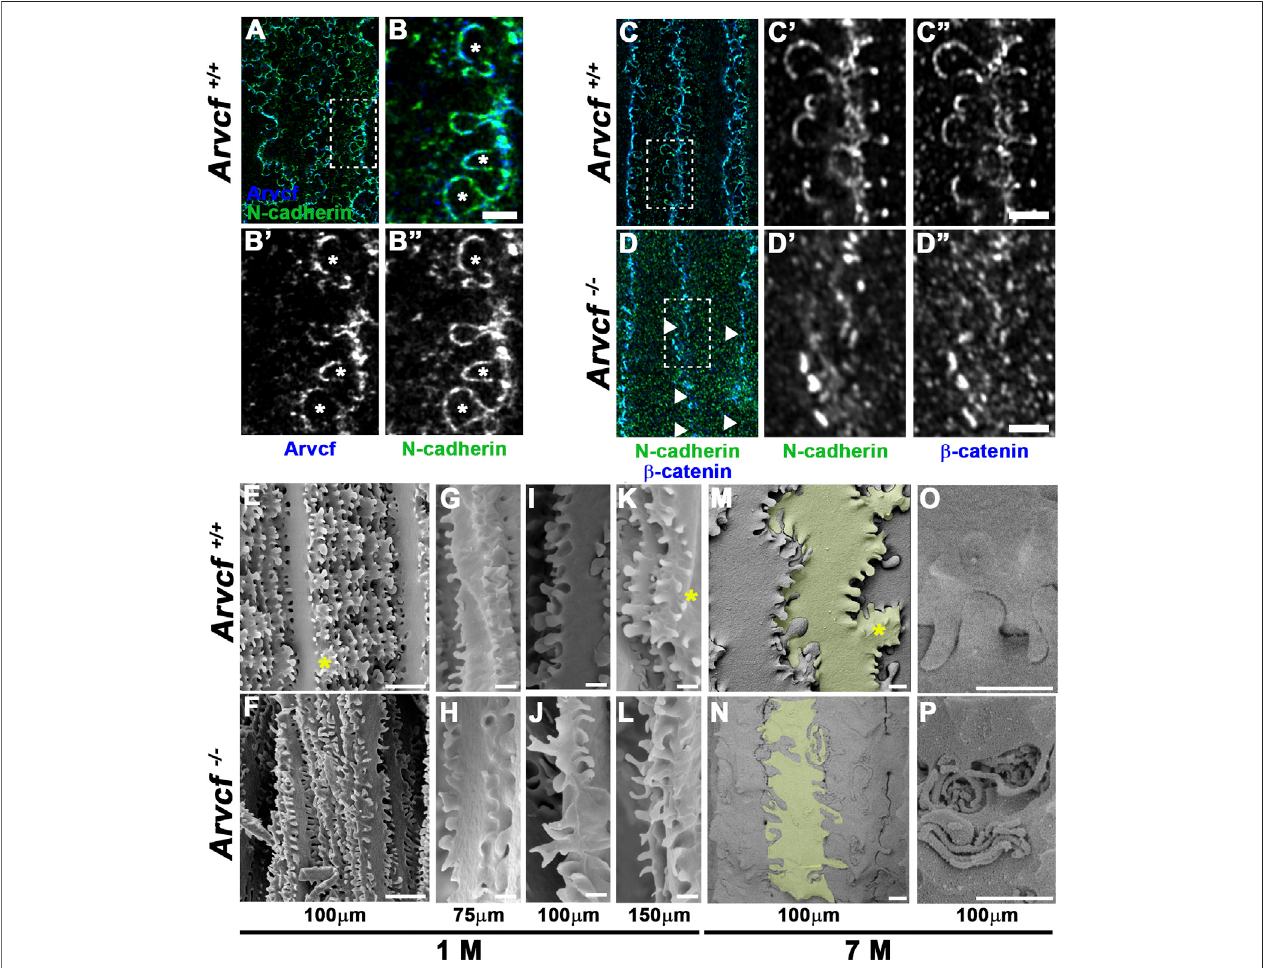
FIGURE 6 | Arvcf is required for lens fi ber cell interlocking protrusion morphology. (A – B) Whole lens fi ber cells immuno fl uorescently co-labeled for Arvcf (blue) and N-cadherin (green). The box in A is magni fi ed in (B) . The asterisks mark interlocking protrusions with lateral margins that are enriched for both Arvcf and N-cadherin. A Plan-Apochromatic CS2 ×100/1.4 oil objective was utilized with a Leica TCS SP8 STED equipped microscope. (C – D) Whole lens fi ber cells immuno fl uorescently co- labeled for β -catenin (blue) and N-cadherin (green). The box in C is magni fi ed in (D) . The arrowheads mark regions of discontinuous signal of both β -catenin and N-cadherin in Arvcf − / − fi ber cells (D) . Also note that interlocking protrusions are not well de fi ned by β -catenin and N-cadherin in Arvcf − / − fi ber cells. A Plan-Apochromat ×63/1.40 oil objective was utilized with a Zeiss Airyscan equipped microscope. (E – P) SEM images of lens fi ber cells from 1 month old (E – N) and 7 month old (M – P) Arvcf +/+ and Arvcf − / − lenseslocatedattheindicateddepthsfromthelenssurface.NotethatwhileN-cadherin/ β -catenindonotdelineateinterlockingprotrusionborders, they arestillpresentinabundancebut areoftenelongated andmisshapen.Asterisksmarkregionswherethecharacteristicpaddle structures appear missing.Lens fi ber cells in (M – N) are shaded to view morphology. Scalebars in (E – F) = 10 microns, (G – P) = 1 micron.